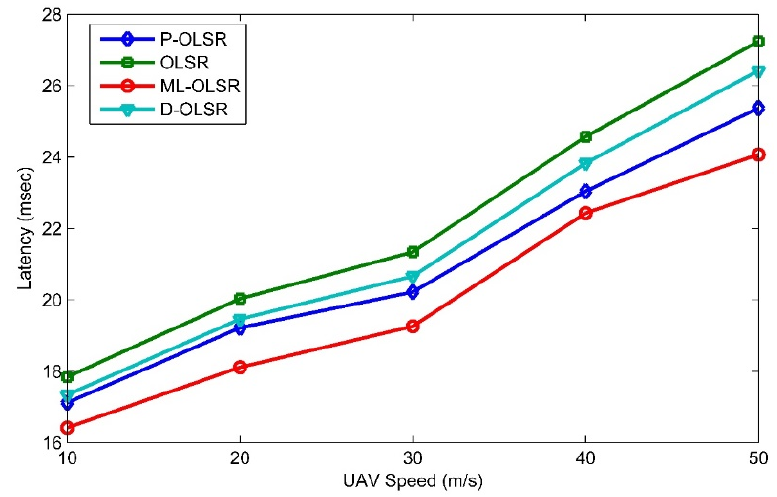
Figure 7. Latency vs. speed of UAVs.